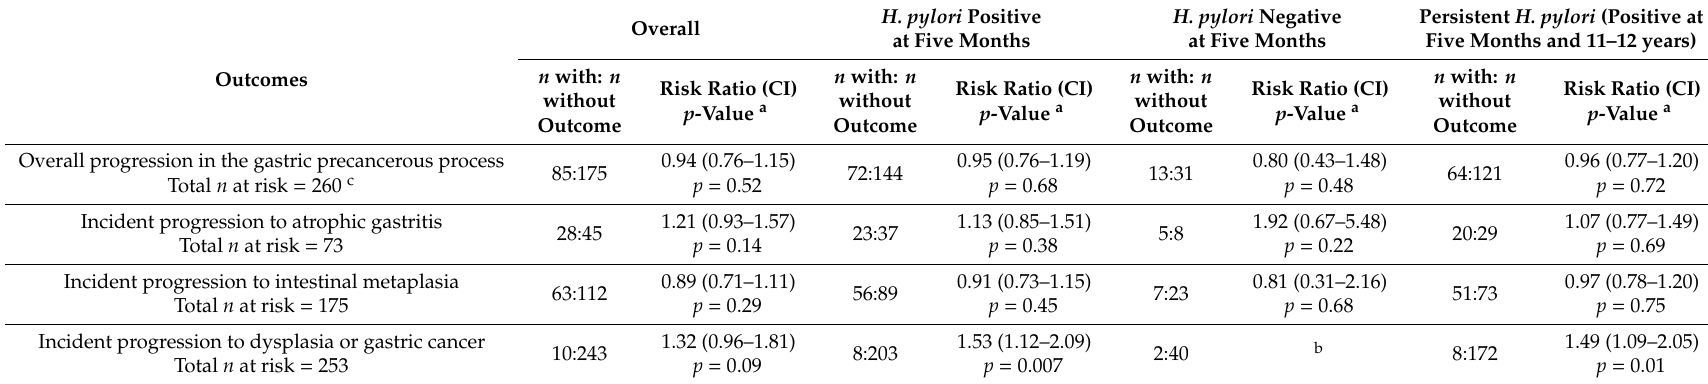
Table 2. Risk ratios for the association between salt intake (defined by the average of the baseline and five-month measures of urinary sodium / creatinine ratio) and progression in the gastric precancerous process (11–12 years compared to